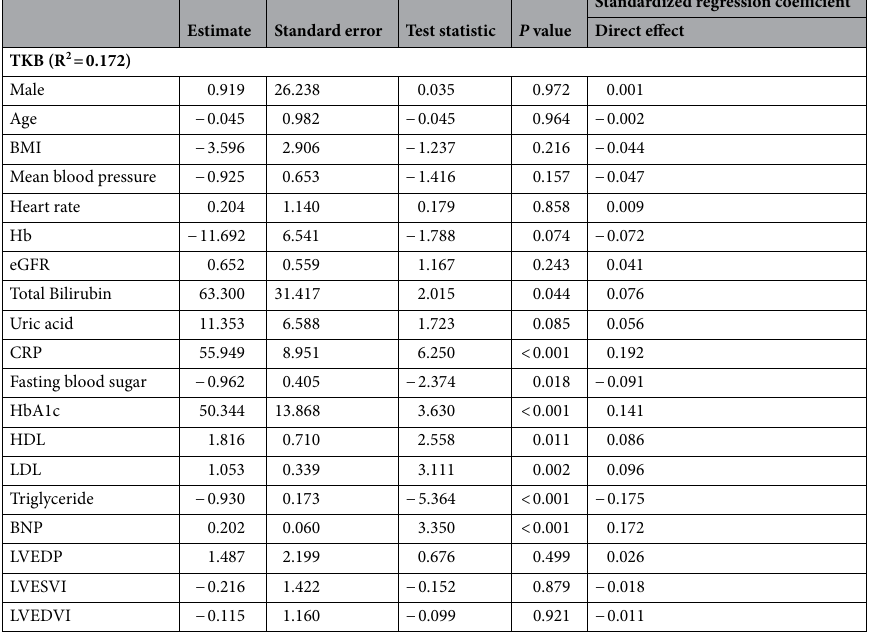
Table 3. The results of the path model (A). R 2 squared multiple correlation, TKB total ketone body, BMI body mass index, Hb hemoglobin, eGFR estimated glomerular filtration rate, CRP C-reactive protein, HDL high-density lipoprotein cholesterol, LDL low-density lipoprotein cholesterol, BNP B-type natriuretic peptide, LVEDP left ventricular end-diastolic pressure, LVESVI left ventricular end-systolic volume index, LVEDVI left ventricular end-diastolic volume